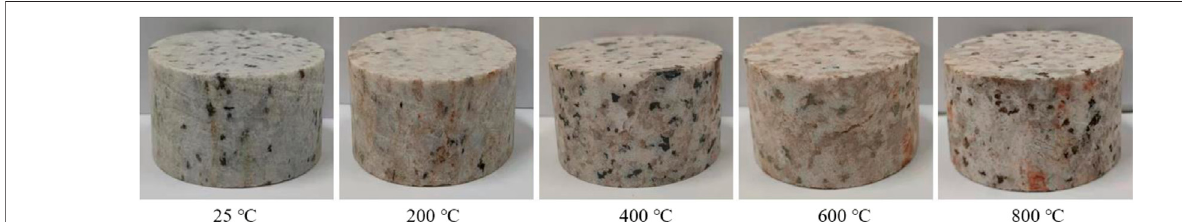
FIGURE 1 | Granite specimen after high-temperature treatment.